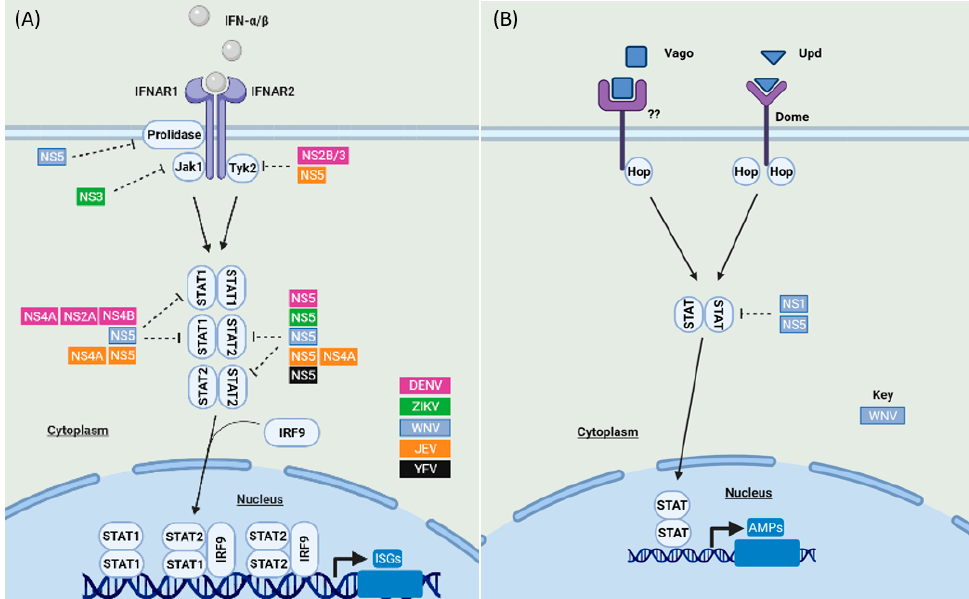
Figure 3. JAK-STAT signaling in response to mosquito-borne flavivirus infection and its antagonism in humans ( A ) and mosquitoes ( B ). ( A ) Following their production and release from human cells, type I IFNs (IFN- α and - β ) bind to their cognate IFN- α receptor subunits 1 or 2 (IFNAR1 and IFNAR2) [86]. IFNAR activation results in phosphorylation of JAK1 and tyrosine kinase 2 (Tyk2) and the subsequent activation and homo- or heterodimerization of STAT1 or STAT2 [87]. STAT proteins then associate with IRF9 forming the interferon-stimulated genes factor 3 (ISGF3) complex which is translocated to the nucleus, promoting the transcription of IFN-stimulated genes (ISGs) [88,89]. ( B ) The JAK-STAT pathway in mosquitoes is activated upon the binding of the unpaired ligand (Upd) to the transmembrane receptor Domeless (Dome), an ortholog of the mammalian type I cytokine receptor during development [10,90]. The JAK-STAT pathway is also activated by the binding of Vago, an insect cytokine-like factor, to an unknown receptor which may suggest that Vago acts in a manner similar to IFNs in human cells [91]. Notably, Vago is induced via the RNAi pathway dsRNA sensor Dicer-2, indicating a cross-talk between these pathways in mosquitoes [92]. The binding of Upd and Vago to their cognate receptors leads to the phosphorylation of Hop, a homolog of the mammalian kinase JAK [10], which then results in phosphorylation of mosquito STAT proteins, which show a high degree of similarity to mammalian STAT5 [93]. STAT proteins are then translocated to the nucleus and consequently induce the transcription of JAK-STAT-regulated genes [77]. However, virus-encoded antagonists of mosquito-borne flaviviruses (DENV in purple, ZIKV in green, WNV in light blue, JEV in orange, YFV in black) are able to block these pathways in humans and mosquitoes. See main text for details.